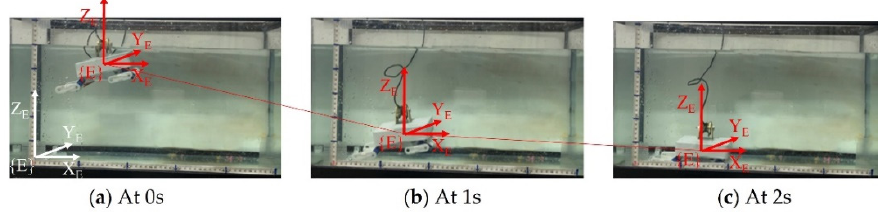
Figure 23. Experiments on diving motion in a swimming motion.